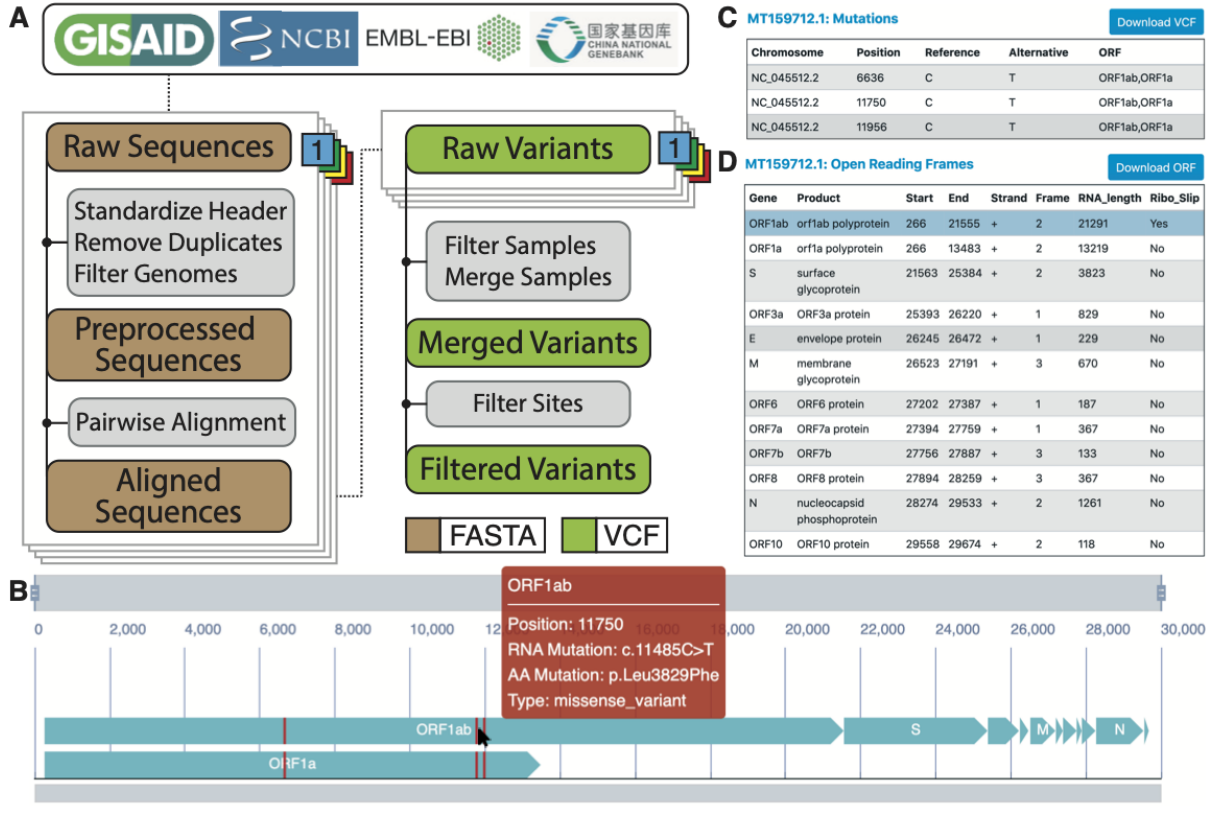
Figure 3. The CoV-Seq pipeline and web interface. (A) Genomic sequences are collected from GISAID, NCBI, ENA, and CNGB. We remove incomplete genomes (length <25,000 nucleotides) and duplicate genomes before alignment with MAFFT against the reference genome NC_045512.2. We use a custom Python script to generate raw variant calls and remove samples with too many mutations, indicative of sequencing error. After merging VCFs, we remove multiallelic sites and variants with the poly-A tail for a filtered set of variants. (B) The interactive genome visualizer shows ORFs (turquoise) and mutations (red). Users can zoom with the top bar and pan with the bottom bar. Hovering over ORF bodies and mutations will trigger pop-up windows for relevant information. (C) The mutation table shows positions, alleles, and intersecting ORFs. (D) The ORF table shows predicted ORF boundaries and supporting information. CNGB: China National GeneBank; ENA: European Nucleotide Archive; GISAID: Global Initiative on Sharing Avian Influenza Data; MAFFT: Multiple Alignment using Fast Fourier Transform; NCBI: National Center for Biotechnology Information; ORF: open reading frame; VCF: variant call